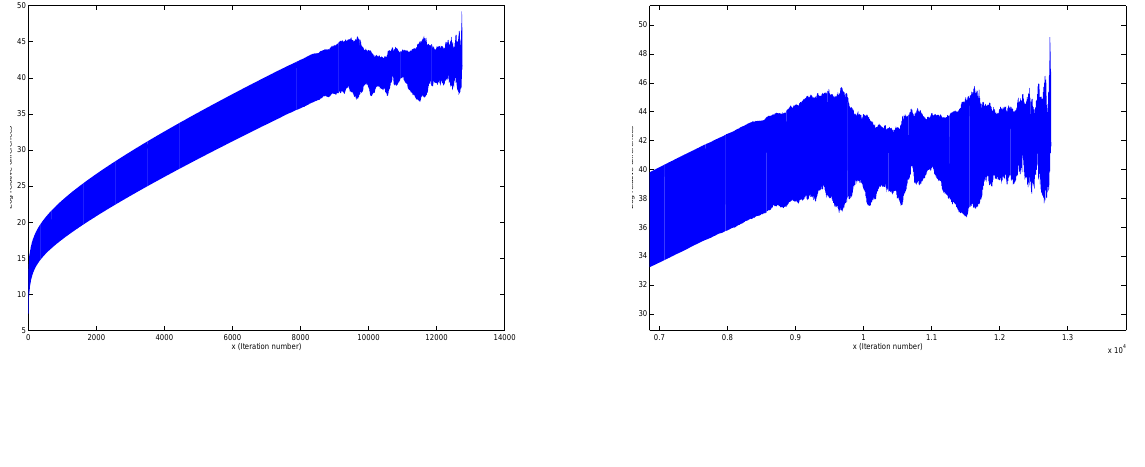
Figure 6. (Left) Example of simultaneous normalization, (Right) Same example zoomed in.